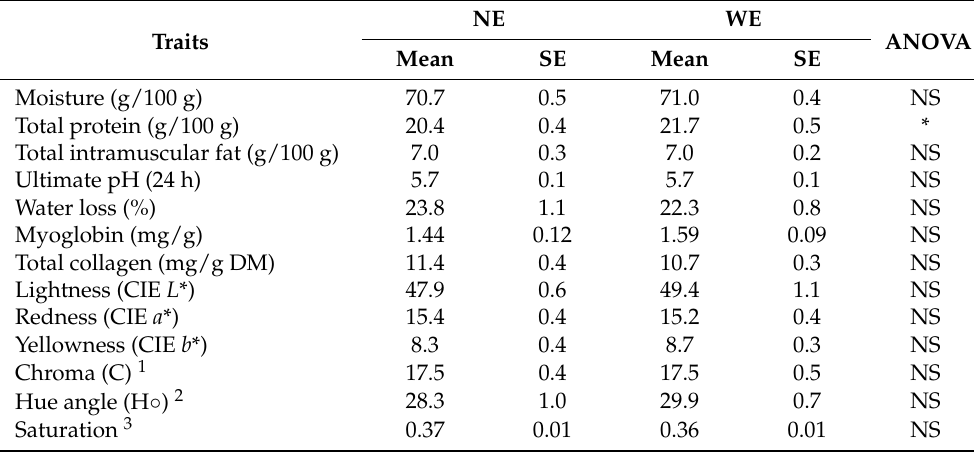
Table 7. Physical-chemical composition of longissimus lumborum from Alentejano pigs kept